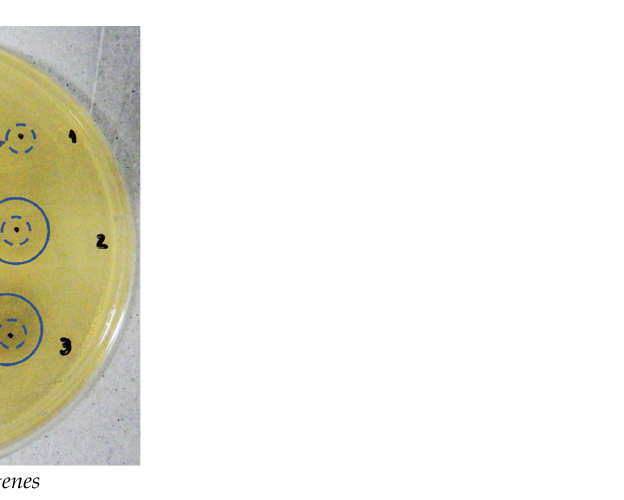
Figure 12. Photographs of the plates sown after incubation for 24 h in an oven at 36 °C. ( a ) Pseudomonas aeruginosa ; ( b ) Escherichia coli ; ( c ) Staphylococcus aureus and ( d ) Streptococcus pyogenes . The numbers correspond to the films under the following conditions: (1) pure PVA; (2) PVA + 0.5% wt. Ag; (3) PVA + 1% wt. Ag; (4) PVA + 2.5% wt. Ag; (5) PVA + 5% wt. Ag; and (6) PVA + 10% wt. Ag. Outer circles represent the inhibition zone, the inner dotted circles represent the polymeric film, and the distance between the inner and outer circles represents the inhibition halo.